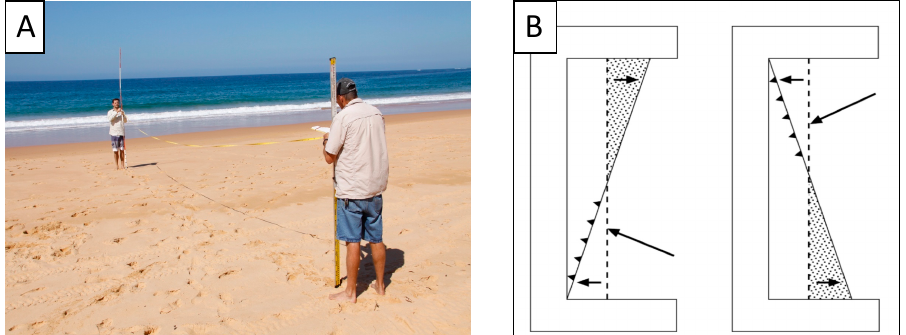
Figure 3. ( A ) Picture of Andy Short and Mitch Harley showing the Emery method (i.e., the use of a simple pole and tape measure) used to survey Narrabeen for the first 25 years (photo credit: Larry Paice). ( B ) A conceptual drawing of embayment beach rotation as described by Short and Trembanis (2004) (Source: